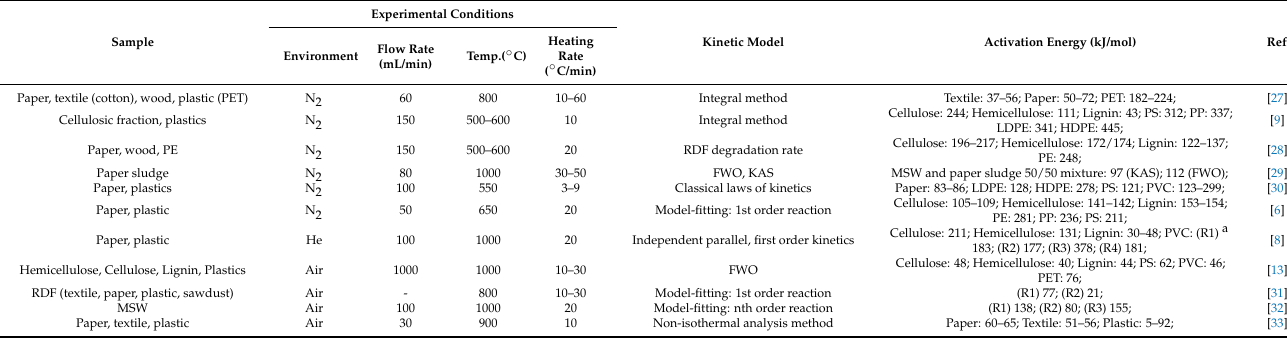
Table 1. Summary of thermochemical properties and kinetics modelling of several refuse derived solid fuel (RDF)’s/MSW’s decomposition based on the literature.